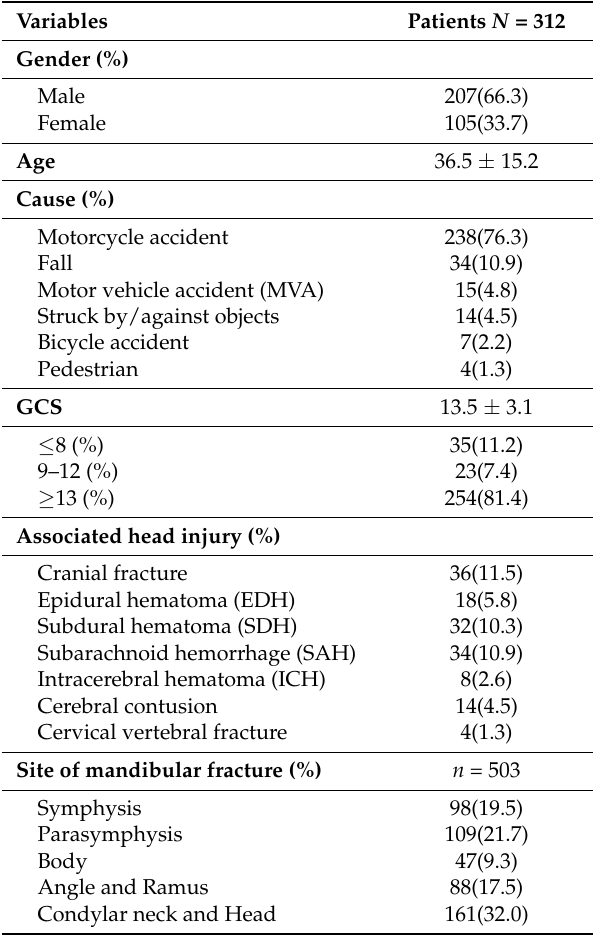
Table 1. Demographics and injury characteristics of adult trauma patients with mandible